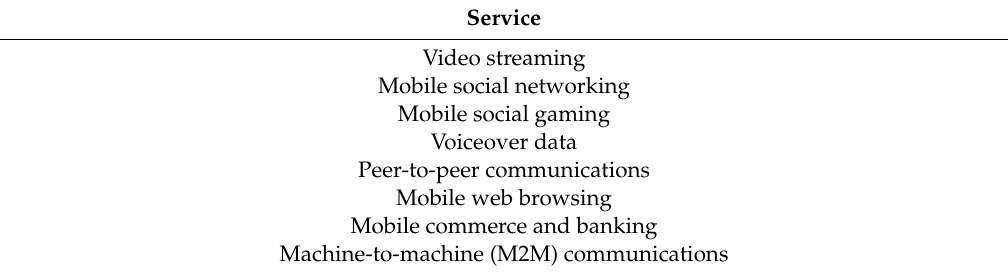
Table 3. Services considered (un-aggregated).